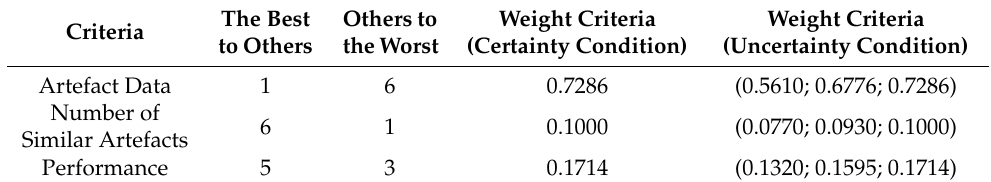
Figure 11. Ground and top floor of the artefact. Source: own elaboration. Table 4. Weight criteria: BMW